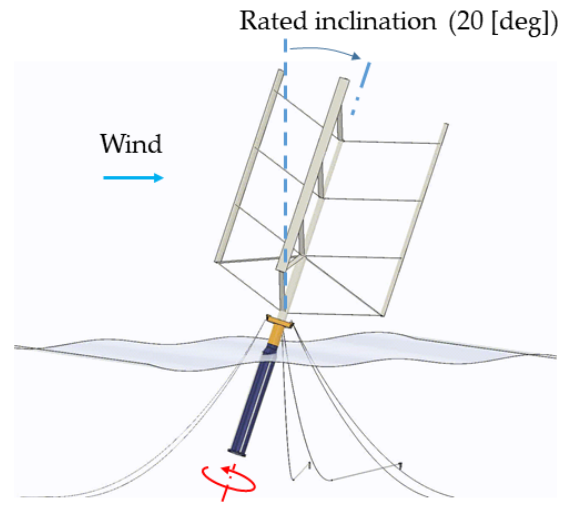
Figure 1. Conceptual diagram of Floating Axis Wind Turbine.